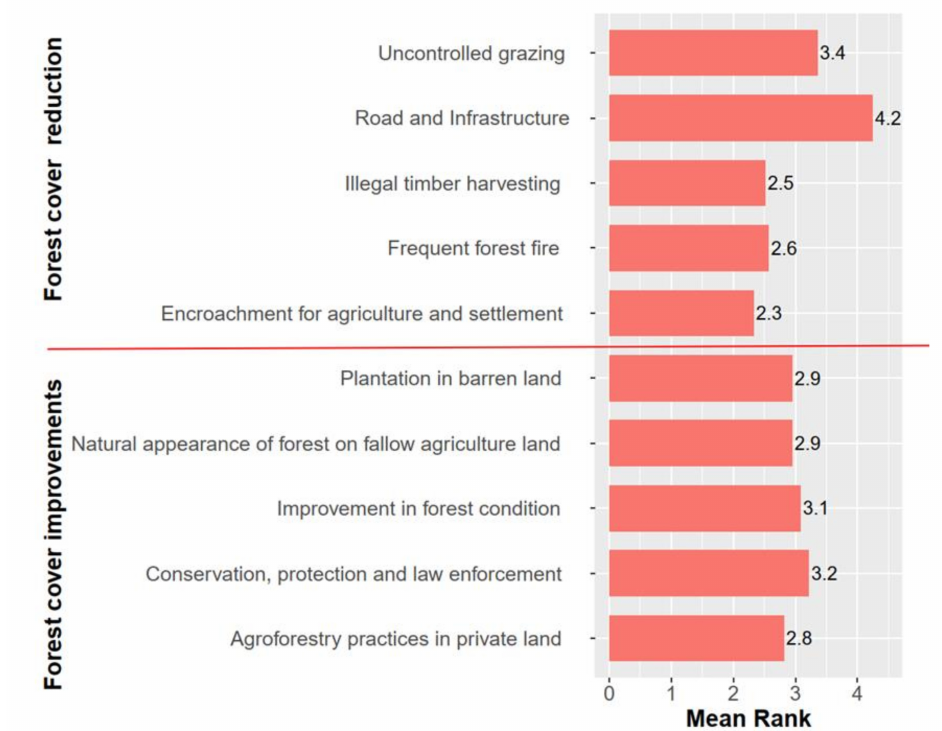
Figure 8. Causes of positive and negative forest cover change. Friedman’s Chi-squared and p -value for forest cover improvements were 1.41 and 0.8,4 respectively, and for forest cover reduction 37.73, and < 0.001,